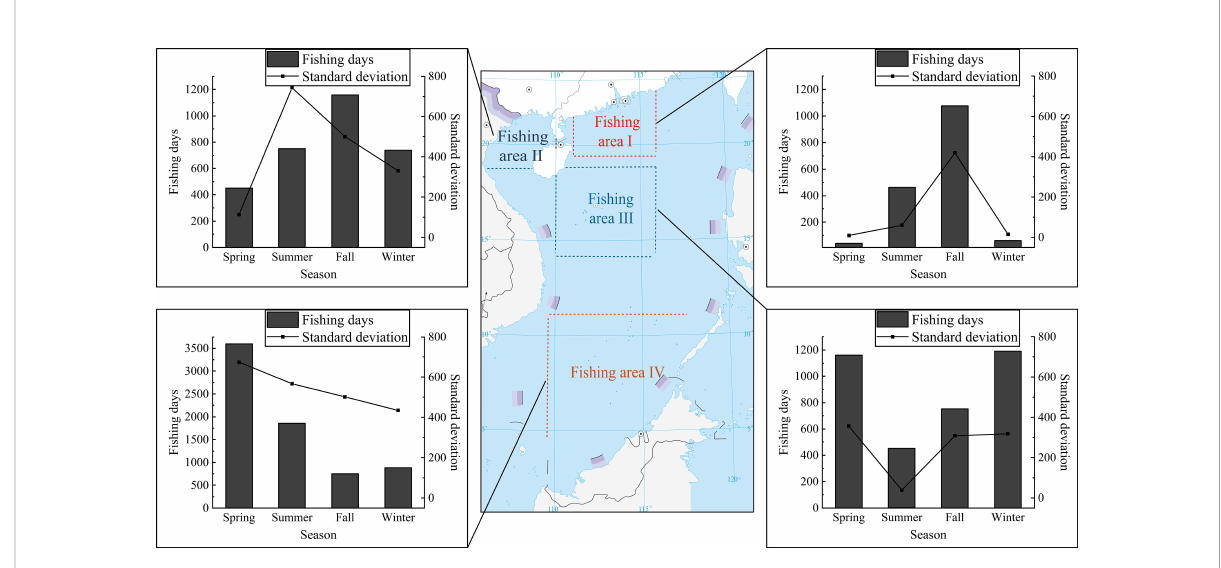
FIGURE 11 Delimitation of fi shing zones and seasonal numbers of fi shing days in different fi shing